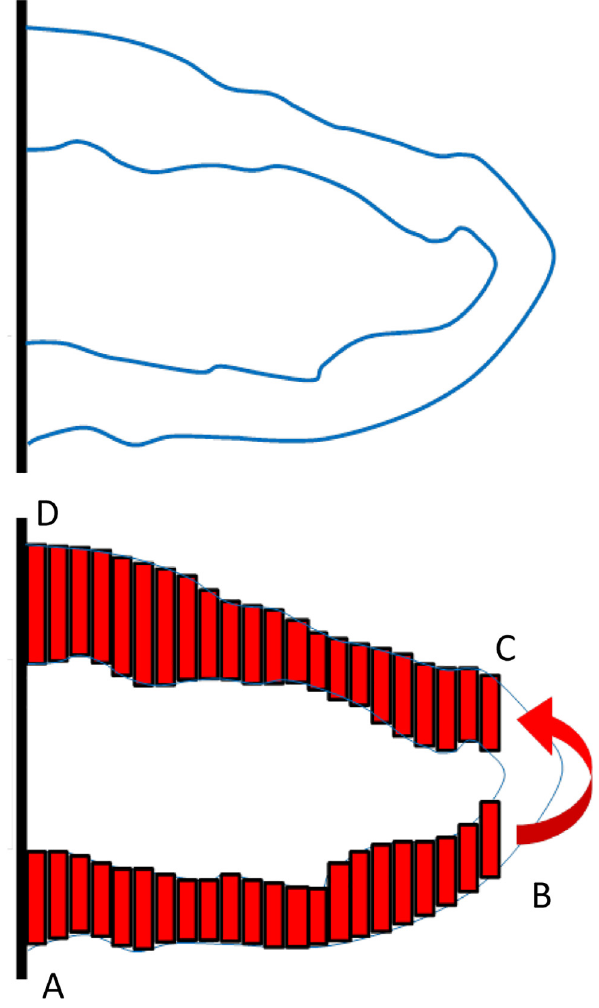
Fig 6. Schematic of the vessel segments assumed for flow